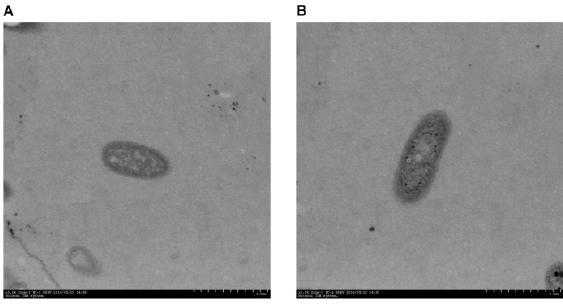
Figure 8. TEM images of P. shigelloides H5 without absorbing Cd 2+ ( A ) and after absorbing Cd 2+ ( B ).